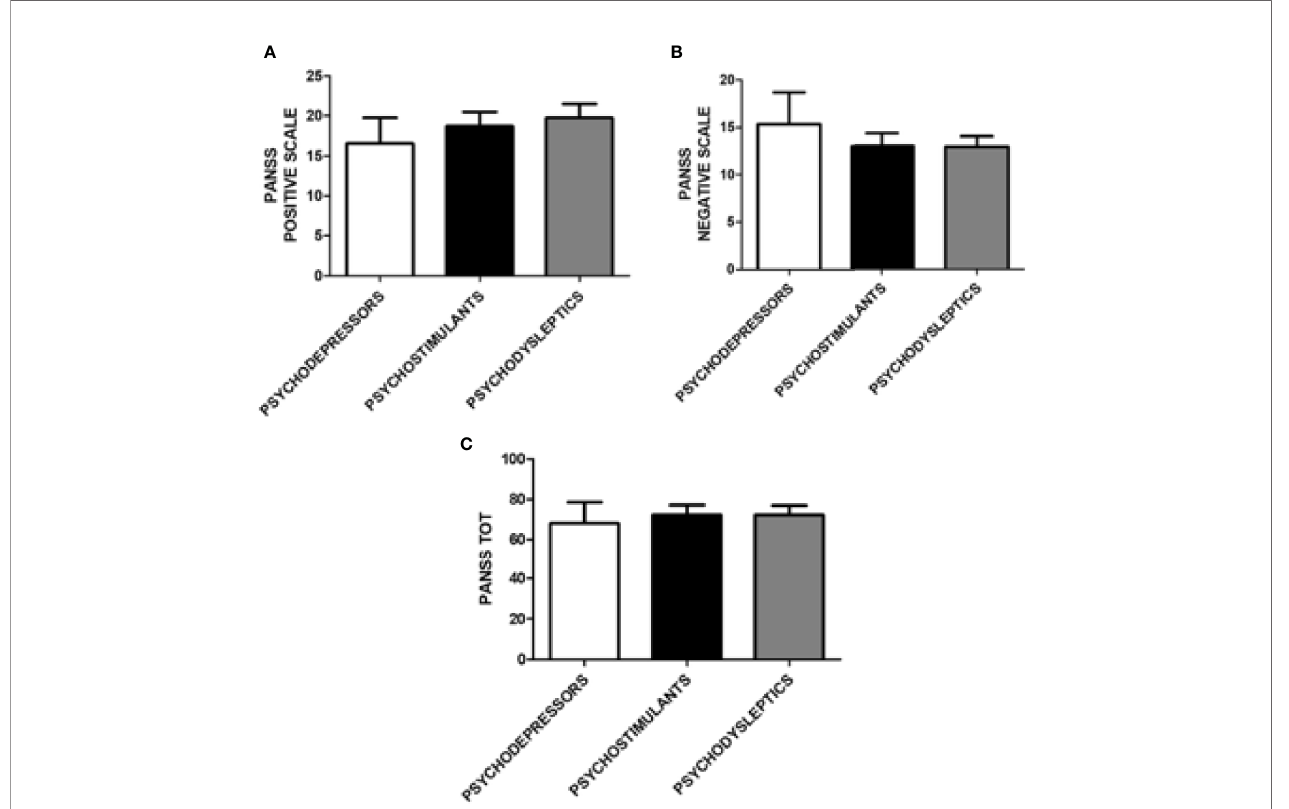
FIGURE 4 | Positive and Negative Syndrome Scale (PANSS) positive, negative, and total scores according to categories of substances. (A) PANSS positive score according to the following categories of substances: psychodepressors, psychostimulants, and psychodyslpetics. (B) PANSS negative score according to the following categories of substances: psychodepressors, psychostimulants, and psychodyslpetics. (C) PANSS total score according to the following categories of substances: psychodepressors, psychostimulants, and psychodyslpetics.